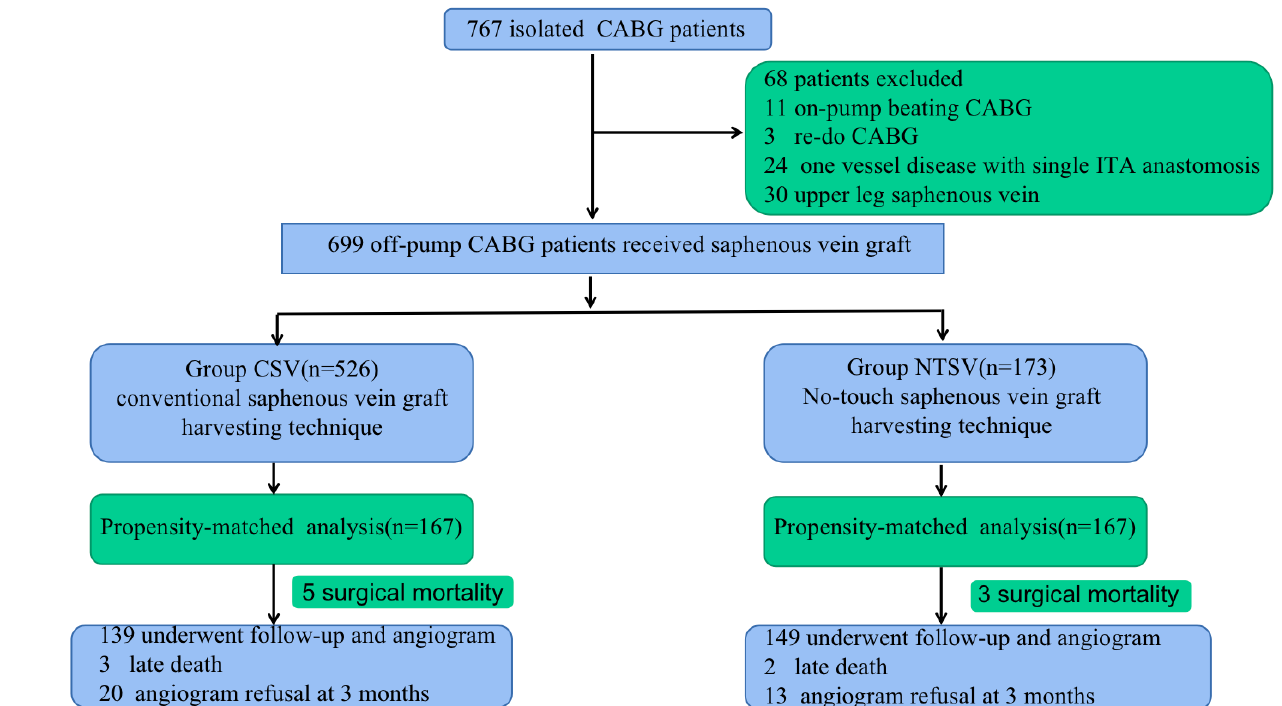
Fig. 1 - Summary flow diagram of enrolled patients. CABG=coronary artery bypass grafting; CSV=conventional saphenous vein; ITA=internal thoracic artery; NTSV=no-touch saphenous